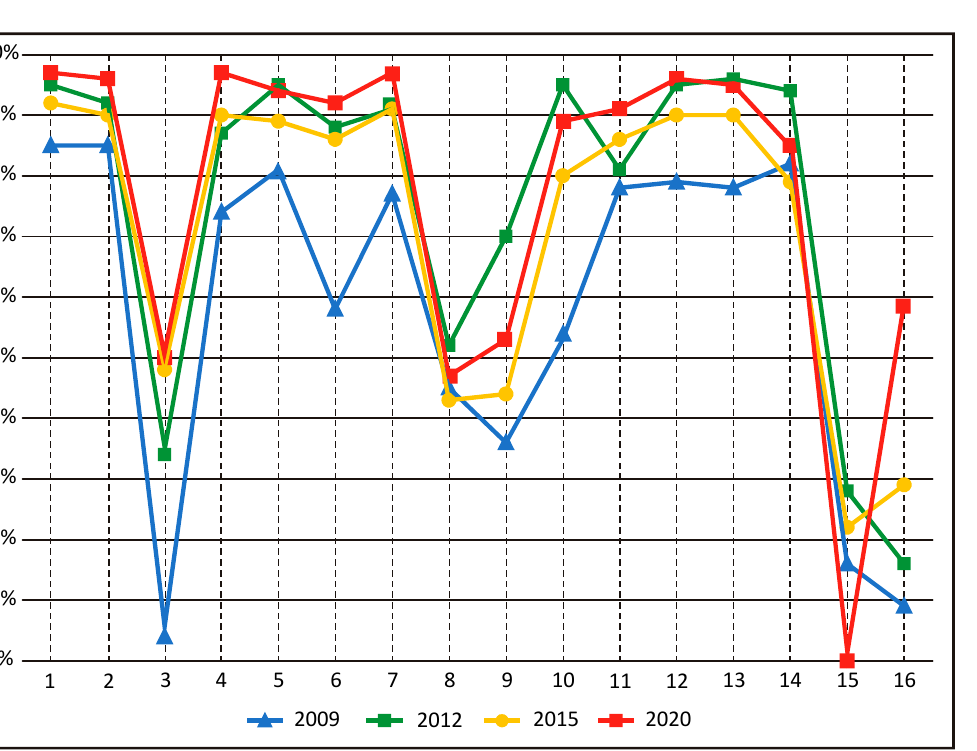
Figure 7. The percentage of websites of municipal offices which met the criteria of functionality in years 2009–2020.